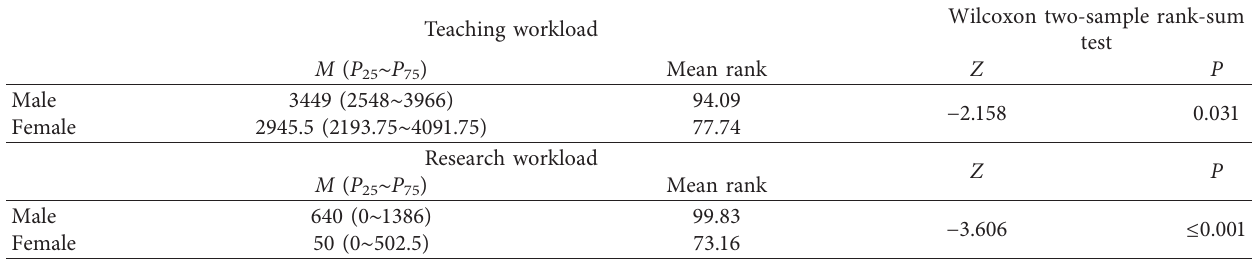
Table 4: Rank-sum test of teaching and research workload of teachers outstanding in teaching.